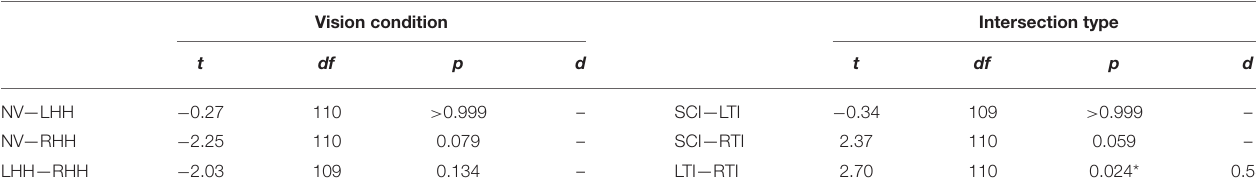
TABLE 2 | Results of the post-hoc analysis for the main effects of vision condition and intersection type ( * indicates p < 0.05). Vision condition Intersection type